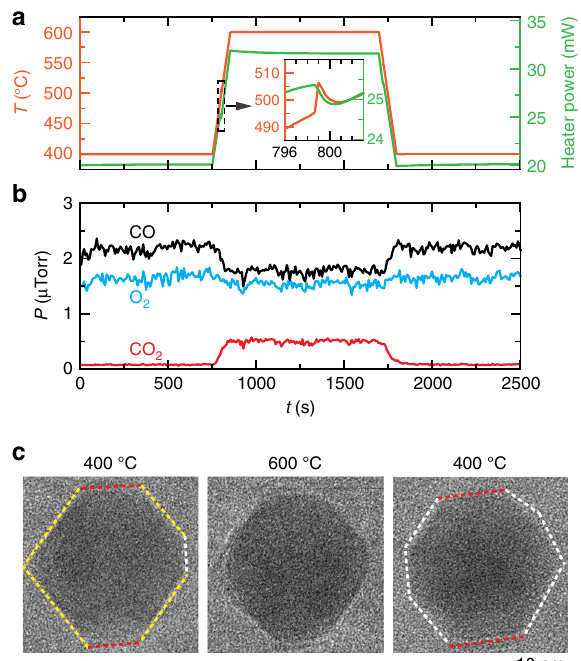
Fig. 3 Pd NPs imaged in a gas environment with CO to O 2 ratio of 1.6. a Measured temperature and heater power pro fi le from the experiment. The inset highlights the temperature spike around the ignition point and the corresponding reduction in heater power expanded from the region demarcated by the dashed box ( y -axes have been re-plotted for the inset to accommodate both curves). b Corresponding measurements of the CO, O 2 , and CO 2 content in the outlet gas stream during the experiment. c Image sequence describing the morphological changes in a Pd NP at different temperatures in the experiment. Dashed lines highlight the outline of the NP where yellow lines correspond to {111} facets, red lines to {100} facets, and white lines to facets that cannot be indexed from the individual images ’ fast Fourier